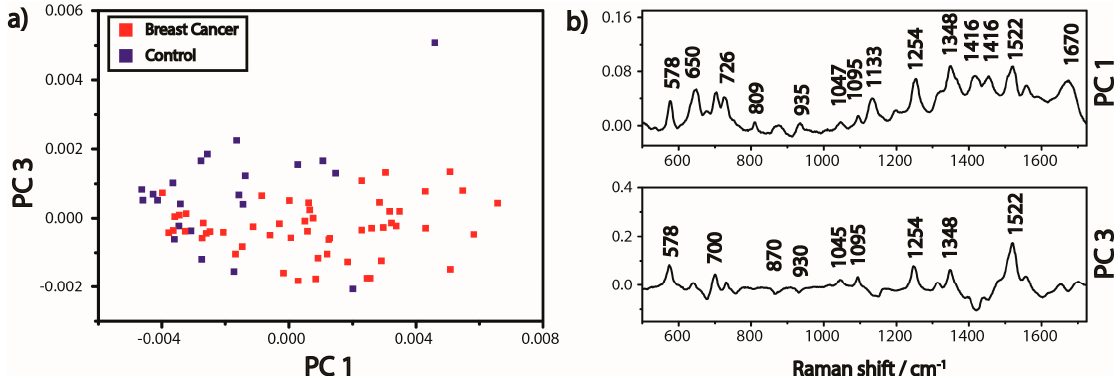
Figure 4. Principal component analysis of SERS acquired from patients with breast cancer (n = 53) and controls (n = 22). Score plot showing the separation of samples based on principal component (PC) 1 and PC 3 ( a ). Loading plots corresponding to PC 1 and PC 3 depicting SERS bands attributed mainly to uric acid, xanthine and hypoxanthine ( b